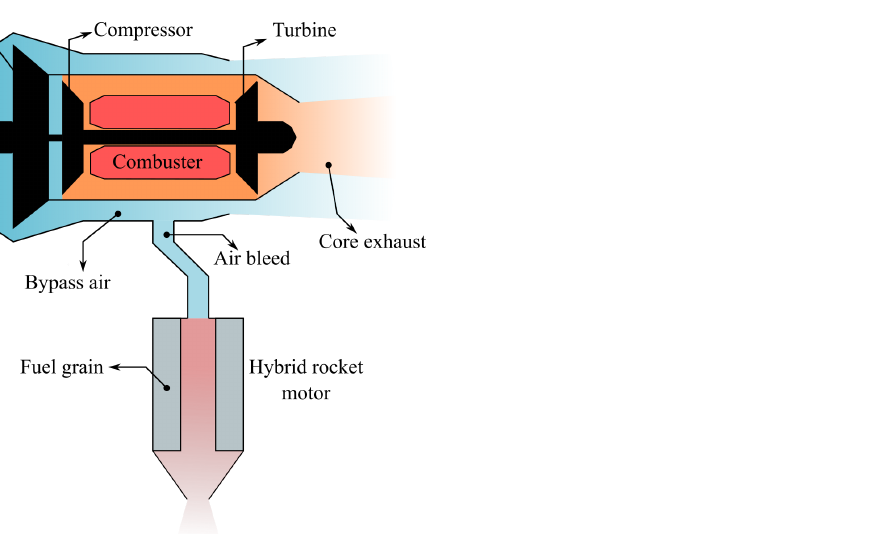
Figure 1. Conceptual diagram of VTOL mechanism (Note that multiple hybrid rockets will be used in the proposed